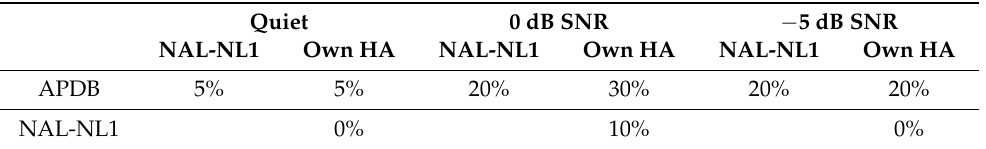
Table 2. Median of the individual speech intelligibility improvements. Each entry represents the improvement of the fitting condition indicated in the respective row over the fitting condition indicated in the respective